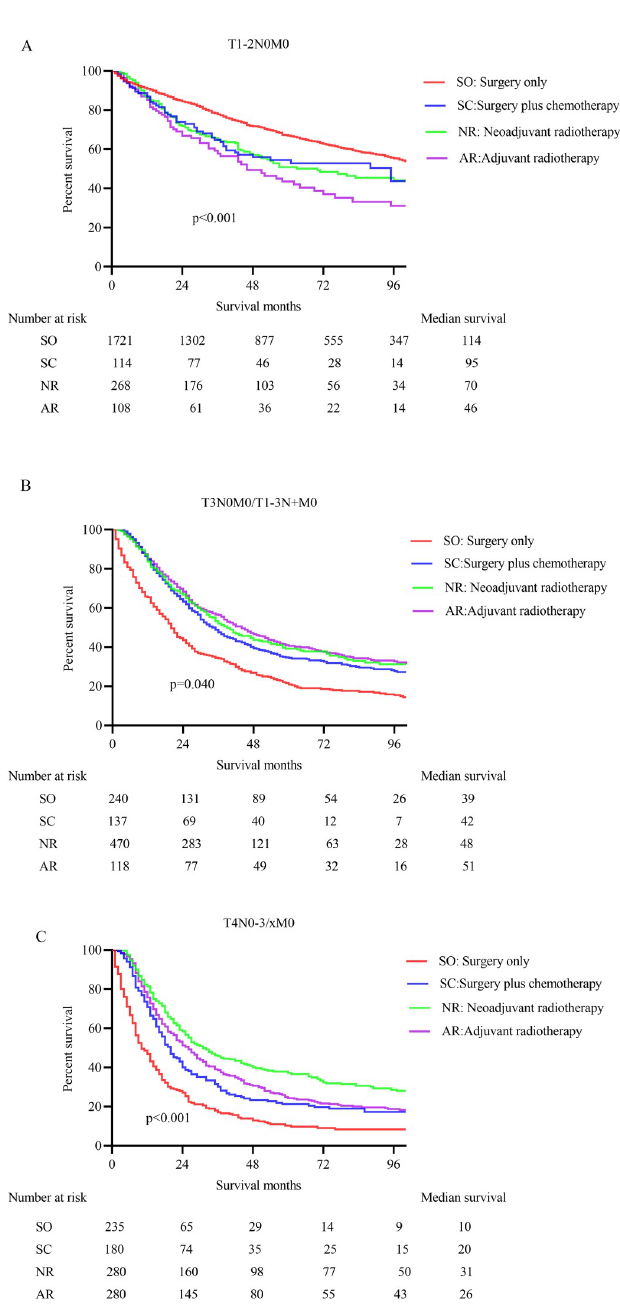
Fig 2. The overall survival estimated with the Kaplan-Meier method for non- metastatic Siewert type II EGA patients. A. The OS analysis of different treatment methods in T1-2N0M0 stage (p < 0.001); B. The OS analysis of different treatment methods in T3N0/T1-3N+M0 stage (p = 0.040); C. The OS analysis of different treatment methods in T4 stage (p < 0.001).